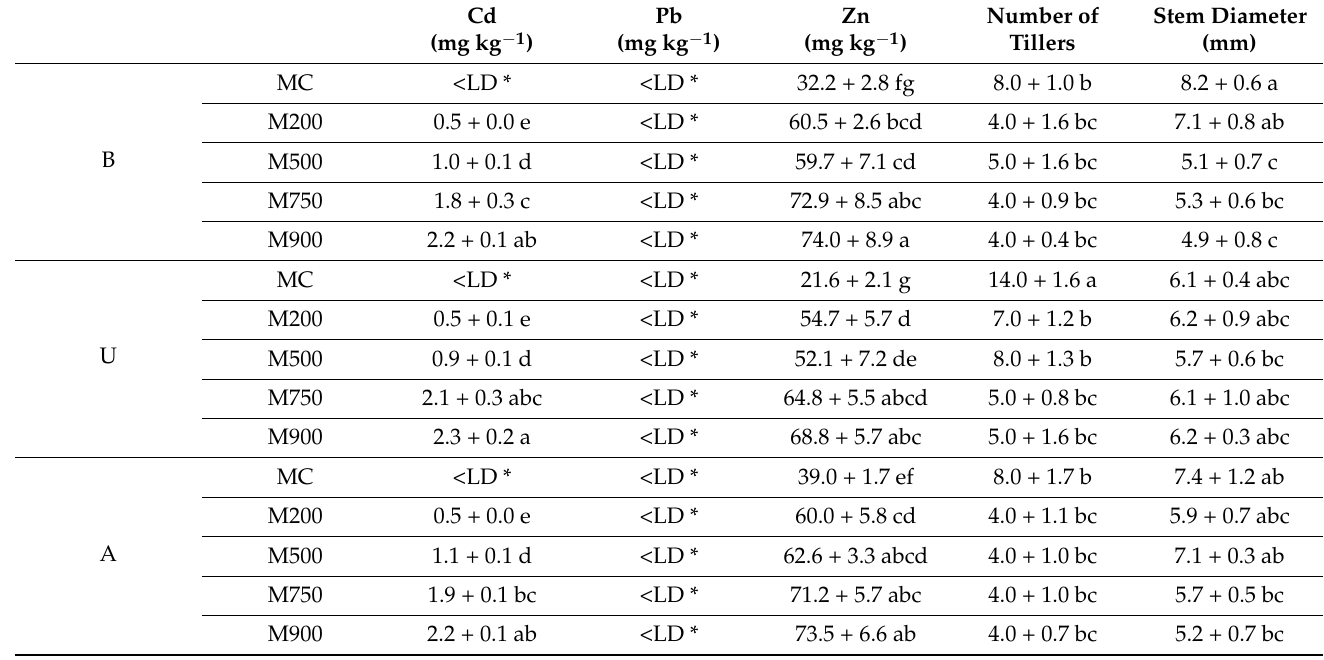
Values are presented as means ± SD. Different letters refer to significant differences between plants (Turkey HSD test, n = 5, p ≤ 0.05). *: Limit of detection (Cd: 0.4 mg kg-1, Pb: 4.3 mg